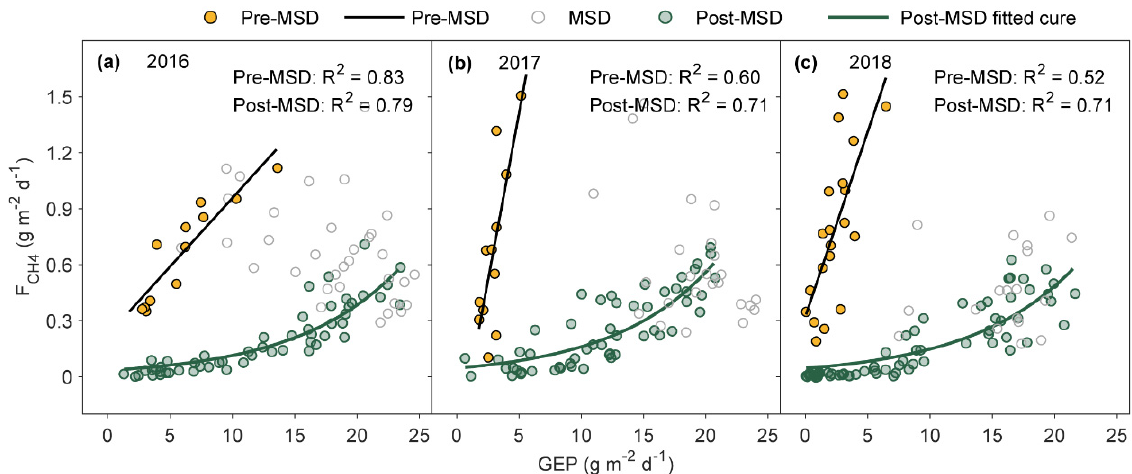
Figure 3. Time series of daily averaged air temperature (yellow lines), 5cm soil temperature (dark yellow lines), photosynthetically active radiation (PAR), volumetric water content (VWC, navy blue lines), rainfall (blue columns), and gross ecosystem productivity (GEP, green forks).